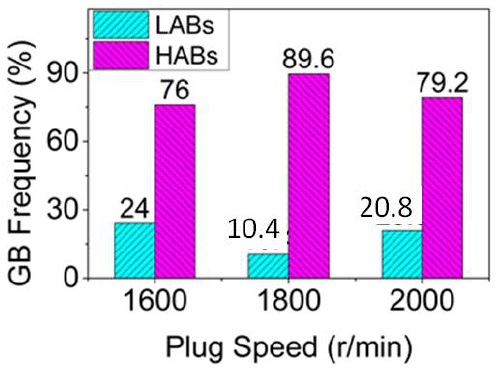
Figure 6. Grain boundary component at different plug rotation speeds.